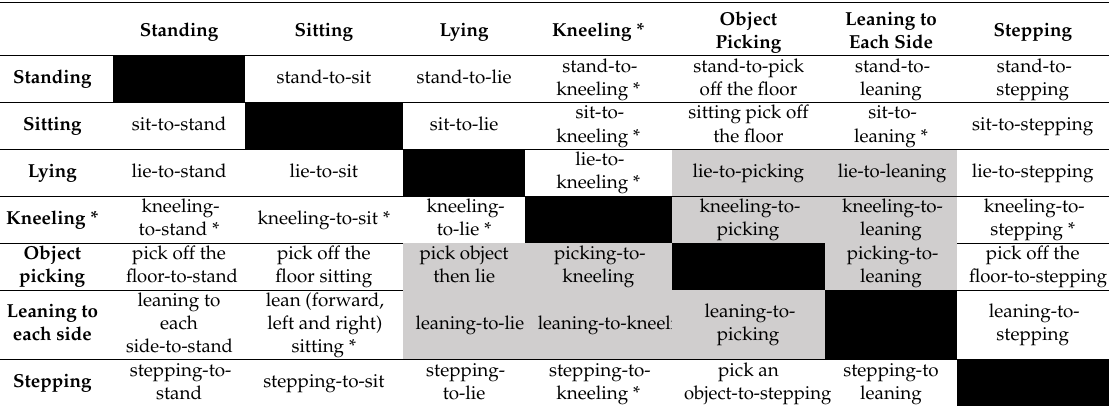
Table 3. Matrix of transfers between non-upright static postures and from non-upright static posture to an upright posture or upright activity. Transitions in grey were deemed unnecessary to include in the protocol as they are either rare events or will not induce a meaningful